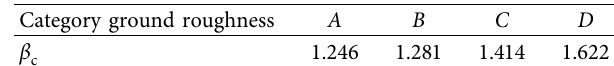
wind load factor of the windage yaw